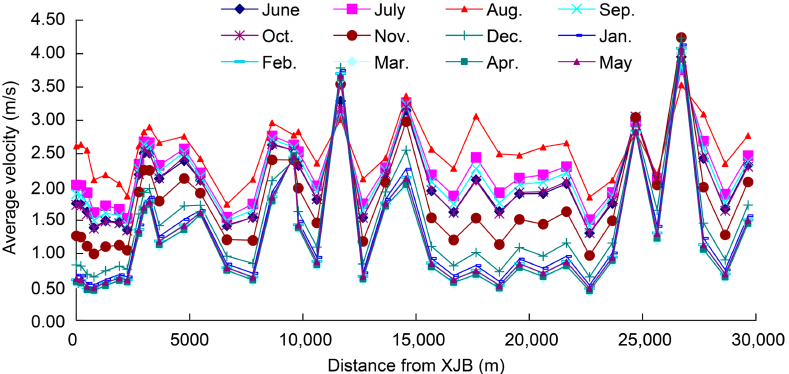
Figure 4. Average velocity for each month during typical dry years in the study